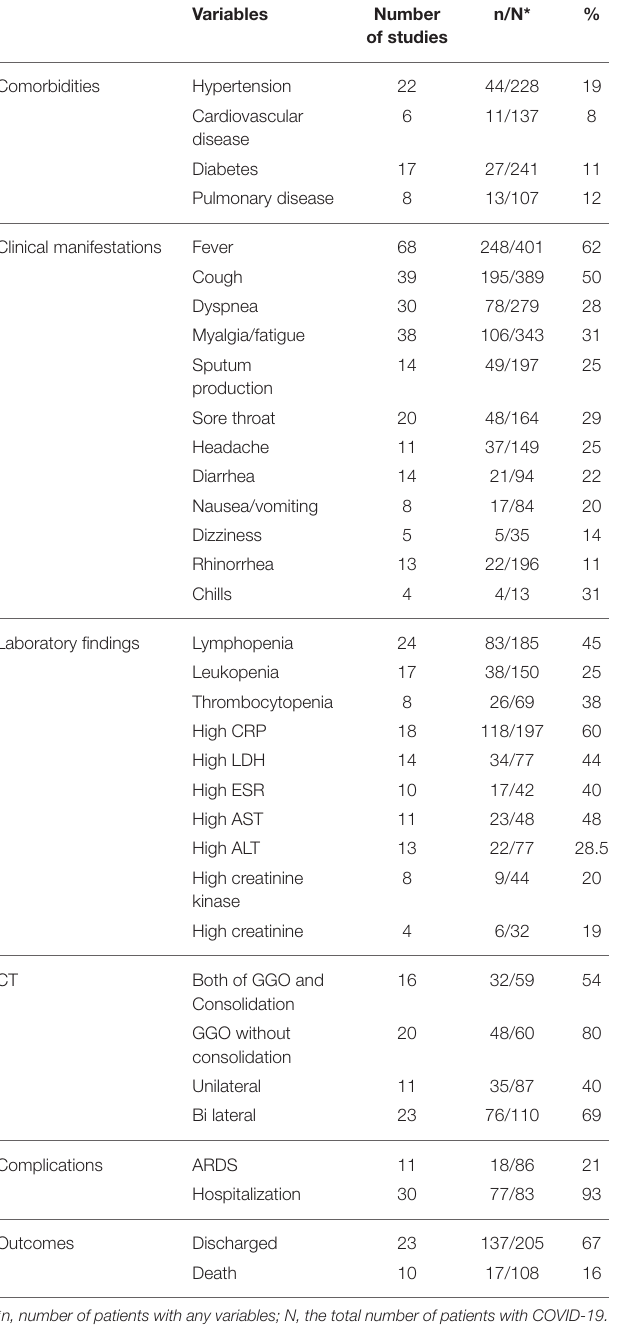
TABLE 2 | Summary of the case report and case series findings. Variables